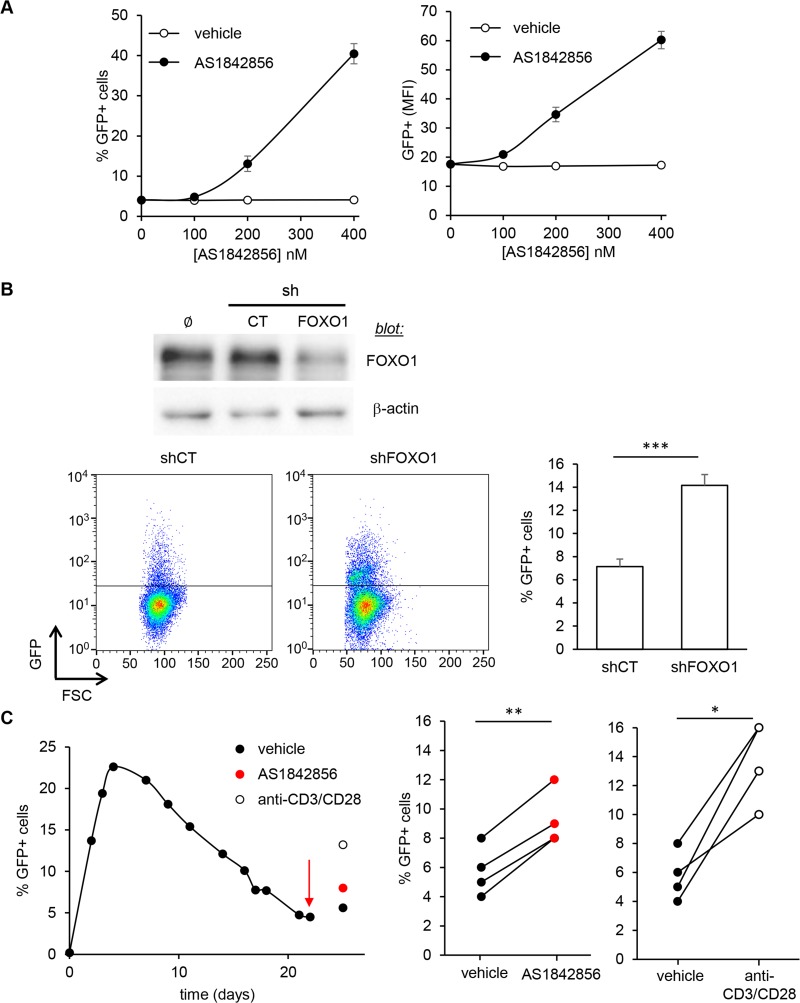
FOXO1 inhibition allows HIV-1 latent provirus reactivation in vitro.(A) J-Lat A1 cells were treated with 400nM of AS1842856 or vehicle only at different concentrations and GFP expression measured by FACS after 2 days of culture. % of GFP-positive cells (left panel) and mean GFP intensity of these GFP-positive cells (right panel) are shown. Mean results +/- SE from 5 independent experiments are shown. (B) FOXO1 expression in J-Lat A1 cells after transduction with control luciferase (CT) or FOXO1 shRNA encoding retroviral particles was measured by western blot (upper panel). GFP expression was measured by FACS in these cells 5 days post-transduction. A representative experiment is shown in the left panel and the results obtained from 3 independent experiments are shown in the right panel. (C) PBT were activated with anti-CD3/anti-CD28-coated beads and infected 3 days later with a VSV-G LTR-GFP-LTR retrovirus and maintained in the presence of IL2 (20 UI/ml). The percentage of GFP-positive cells was then followed by FACS at different time points. Cells were then treated (arrow) with the vehicle only, AS1842856 (500nM) or anti-CD3/anti-CD28-coated beads as a positive control. Latency reversal was assessed by measuring GFP fluorescence after 3 days of reactivation. A representative experiment is shown in the left panel. Shown in the right panels are the results obtained from 4 independent experiments with different donors after the 3-day reactivation period.